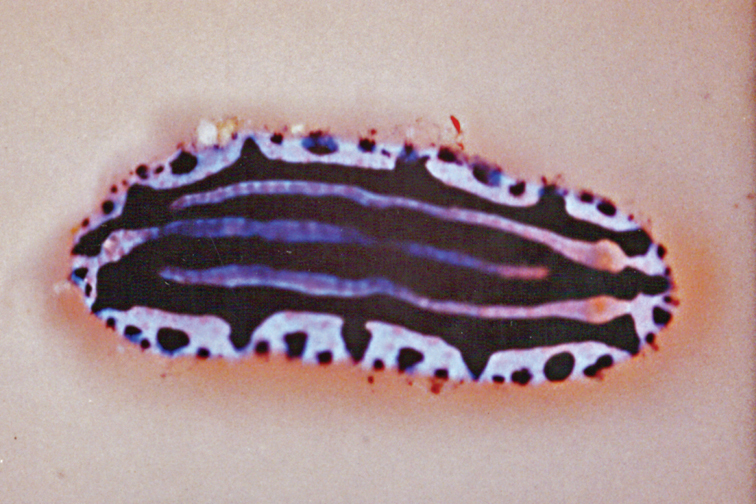
Phyllidiopsis sphingis, 19 mm, Maldives, photo: RC Anderson.